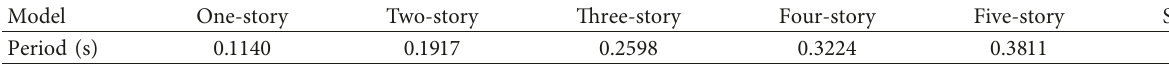
Table 1: Natural vibration periods of the six buildings studied.